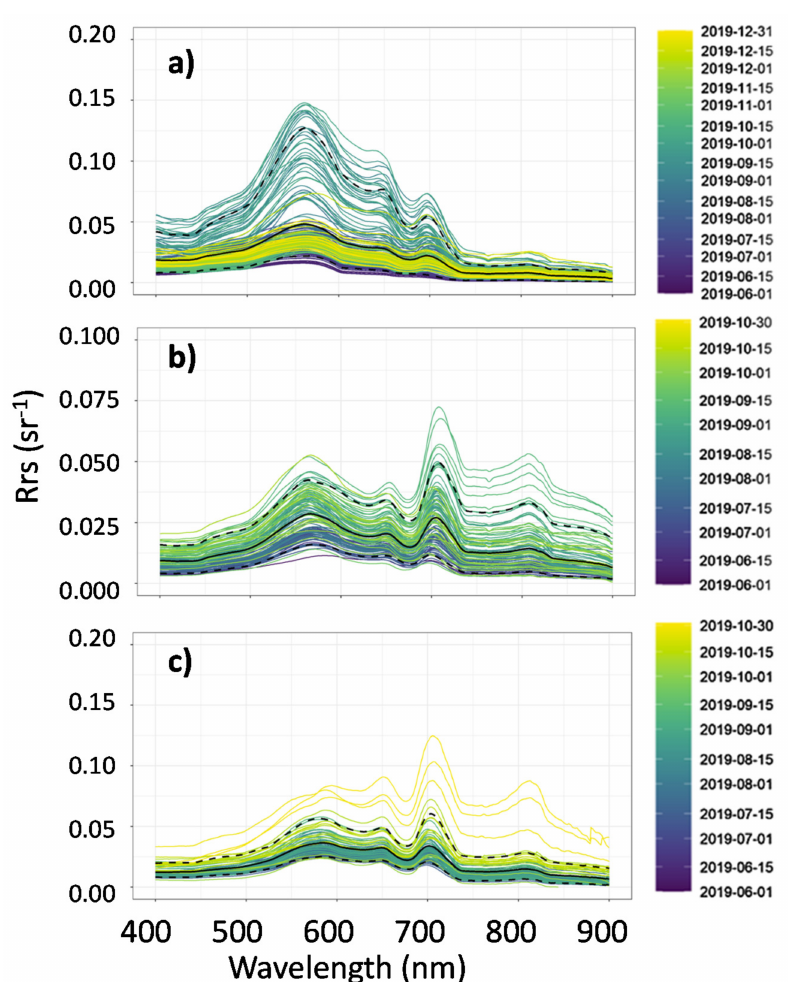
Figure 4. Daily averages of Remote sensing reflectances (Rrs) for the period of measurement in Lake Trasimeno from 1 June to 31 December 2019 ( a ), Curonian Lagoon ( b ), and Lake V õ rtsjärv ( c ) from 1 June to 31 October 2019. Black continuous line is the Rrs mean value computed over the entire period and black dotted lines are the relative 5th and 95th percentiles.